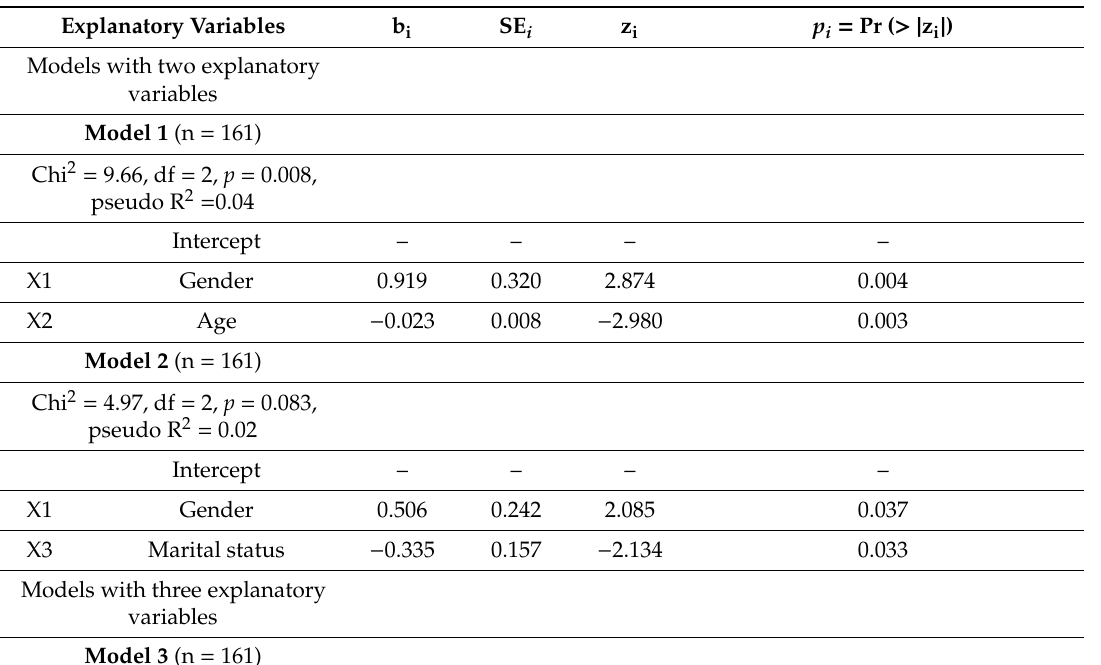
Table 6. Results of logistic regression analysis and odds ratio of logistic regression model in the group of caregivers. Explained variable: Unmet needs (0—more unmet needs, 1—fewer unmet needs) in